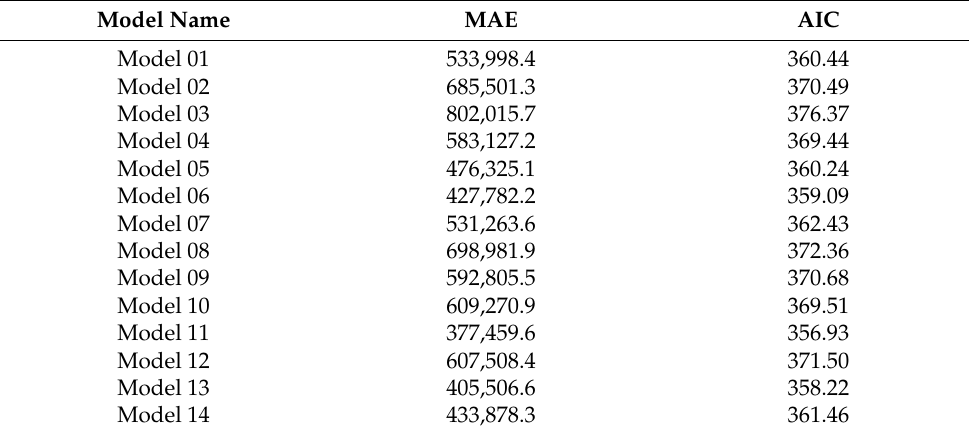
Table 10. MAE and AIC values for the proposed models.